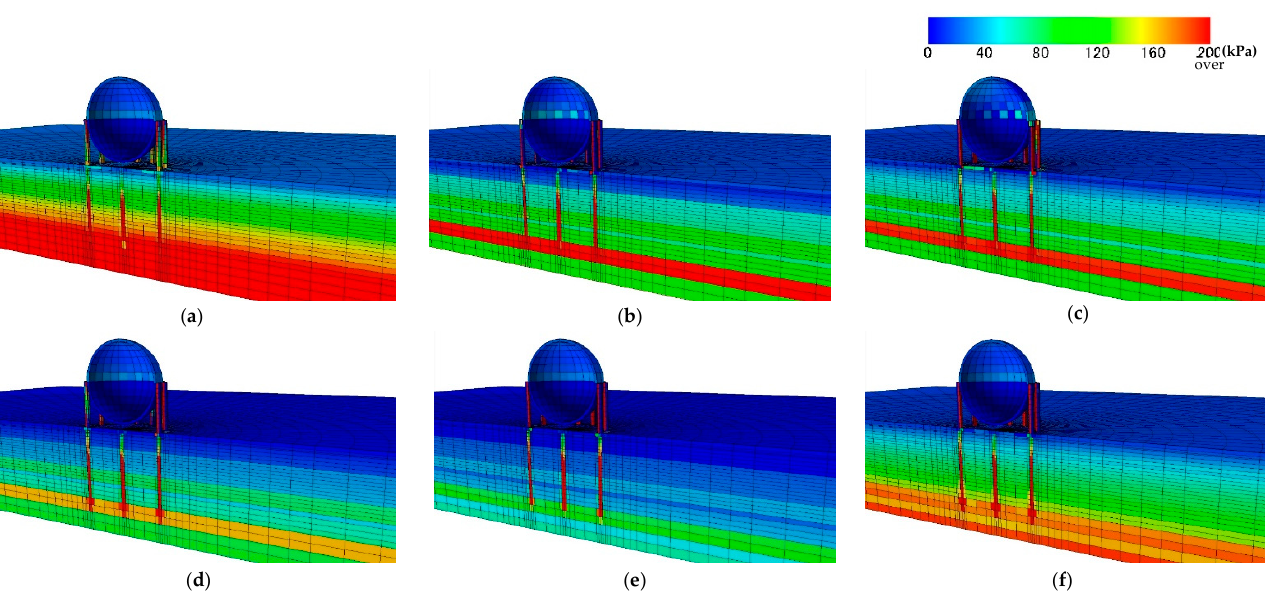
Figure 21. Changes in mean effective stress over time, seismic motion (B): ( a ) immediately before the EQ; ( b ) 7 s after the start of the EQ; ( c ) 7.5 s; ( d ) 10.5 s; ( e ) end of the EQ; ( f ) end of consolidation.